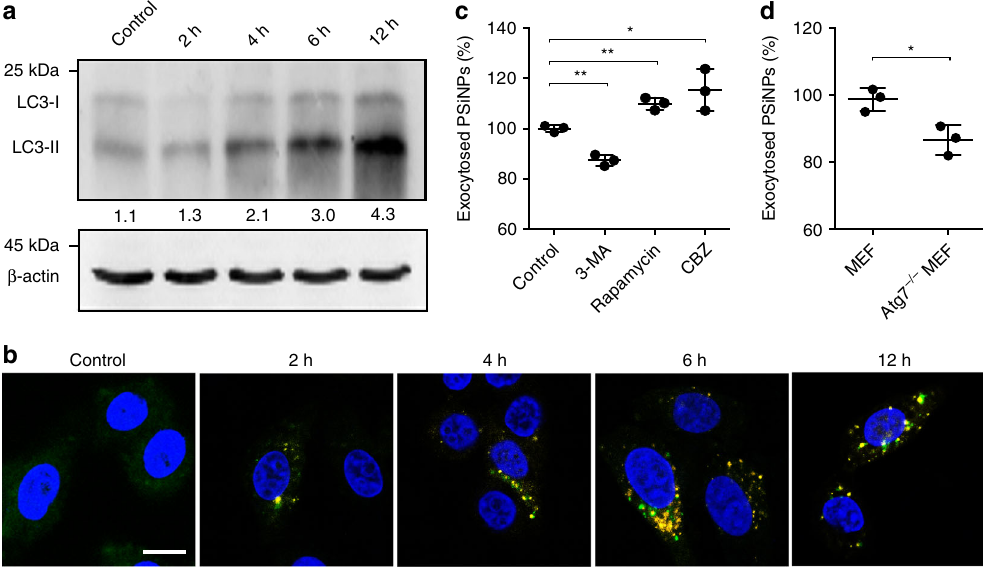
Fig. 2 Role of autophagy in the exocytosis of PSiNPs. a LC3-I and LC3-II expression in Bel7402 cells treated with 200 μ g mL − 1 PSiNPs for different time intervals by western blot. The number underneath each group in the immunoblotting indicates the relative ratio of LC3-II to LC3-I of the corresponding group. b Confocal fl uorescence microscopic images of EGFP-LC3-transfected Bel7402 cells after treatment with 200 μ g mL − 1 PSiNPs for different time intervals. Scale bar: 20 μ m. c Relative amount of the exocytosed PSiNPs in Bel7402 cells after treatment with 200 μ g mL − 1 PSiNPs for 6 h, followed by washing with PBS and then incubating in fresh medium with or without 5 mM of 3-MA, 200 nM of rapamycin or 30 μ M of CBZ for another 16 h by ICP- OES. d Relative amount of the exocytosed PSiNPs in wild type and Atg7 − / − MEF cells after treatment with 200 µ g mL − 1 PSiNPs for 6 h, followed by washing with PBS and then incubating in fresh medium for 16 h by ICP-OES. Data were represented as mean ± SD ( n = 3). * P < 0.05, ** P < 0.01 (one-way ANOVA with Fisher ’ s LSD test for c and unpaired two-tailed Student ’ s t test for d ). Source data are provided as a Source Data fi